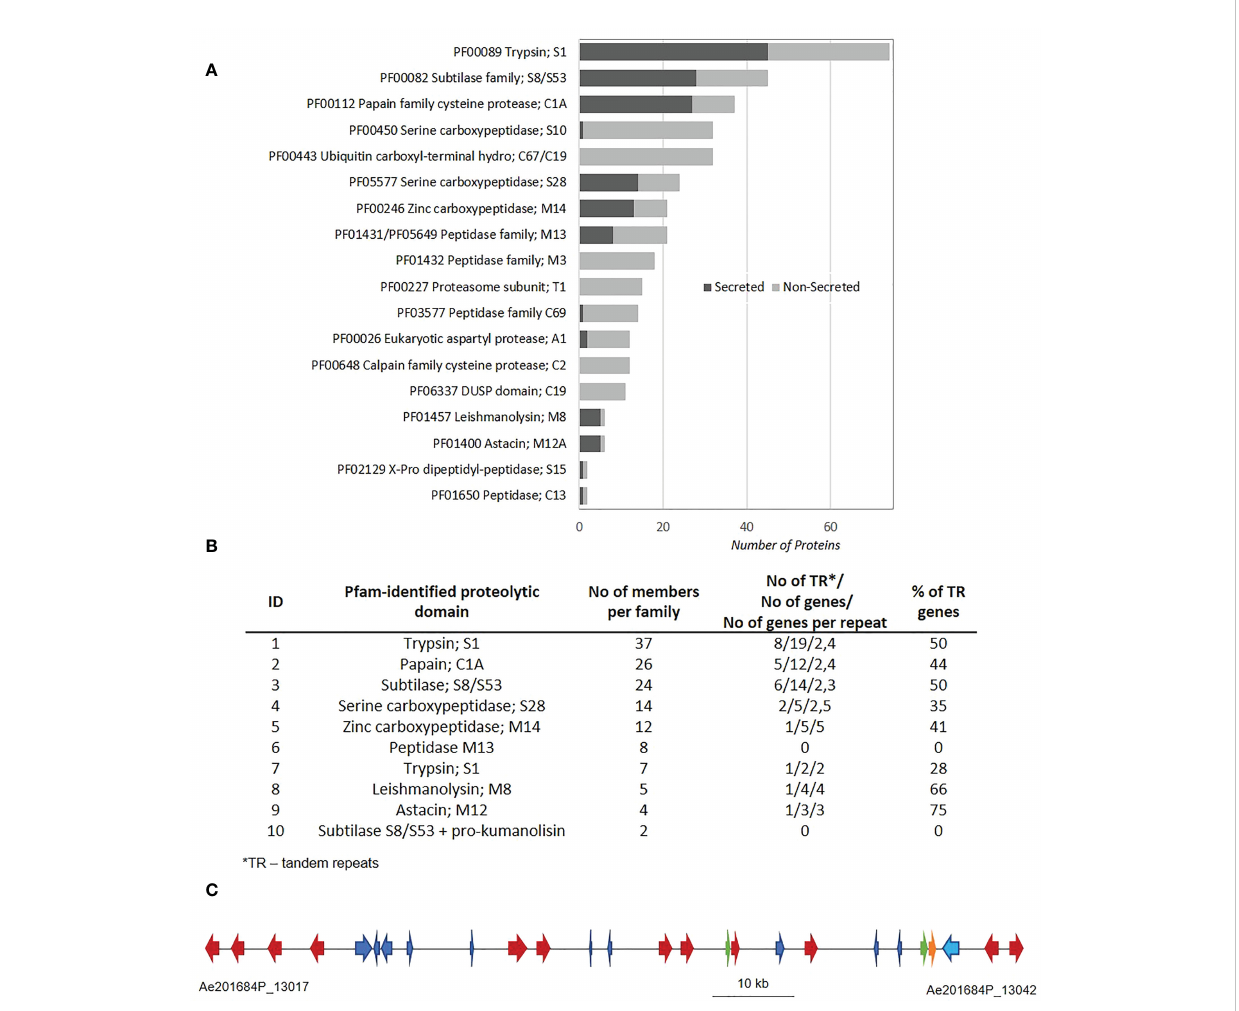
FIGURE 1 Mining of protease sequences from A. euteiches genome. (A) Repartition of proteolytic enzymes between secreted and non-secreted proteins in A. euteiches ATCC201684 genome. Proteolytic domains determined by InterProScan software against Pfam database. Secreted proteins (dark-grey) correspond to proteins with a predicted signal peptide (+SP) and without a predicted transmembrane domain (-TM). Data extracted from AphanoDB database (Madoui et al., 2007; Gaulin et al., 2018). (B) Distribution of secreted proteolytic enzymes in multigene families and tandem repeats in A. euteiches . Multigene families determined using Markov Cluster Algorithm (MCL) with a blast e-value < 1e − 30 , MCL in fl ation rate 1.5. Proteins considered in Tandem Repeats (TR), when having adjacent copy (blast e-value < 1e − 80 , coverage > 80%). (C) A 97 kb genome region (between Ae201684P_13017 and Ae201684P_13042 genes) in 2,7 Mb contig of A. euteiches enriched in tandemly repeated secreted subtilases (multigene family 3). The cluster contains 26 genes, corresponding to 11 secreted subtilases (red arrows), 1 non-secreted subtilase (orange arrow), 2 small secreted proteins (SSP, green arrows) and 13 non-secreted proteins with various functions (blue arrows). See Supplementary Table S4 for the detailed description of proteins present in the